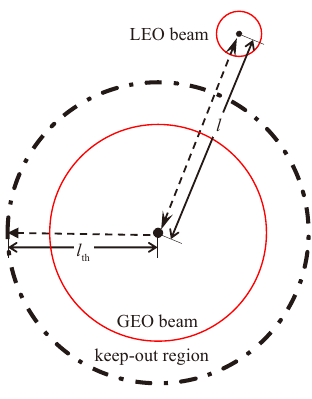
Figure 5. Schematic of the keep-out